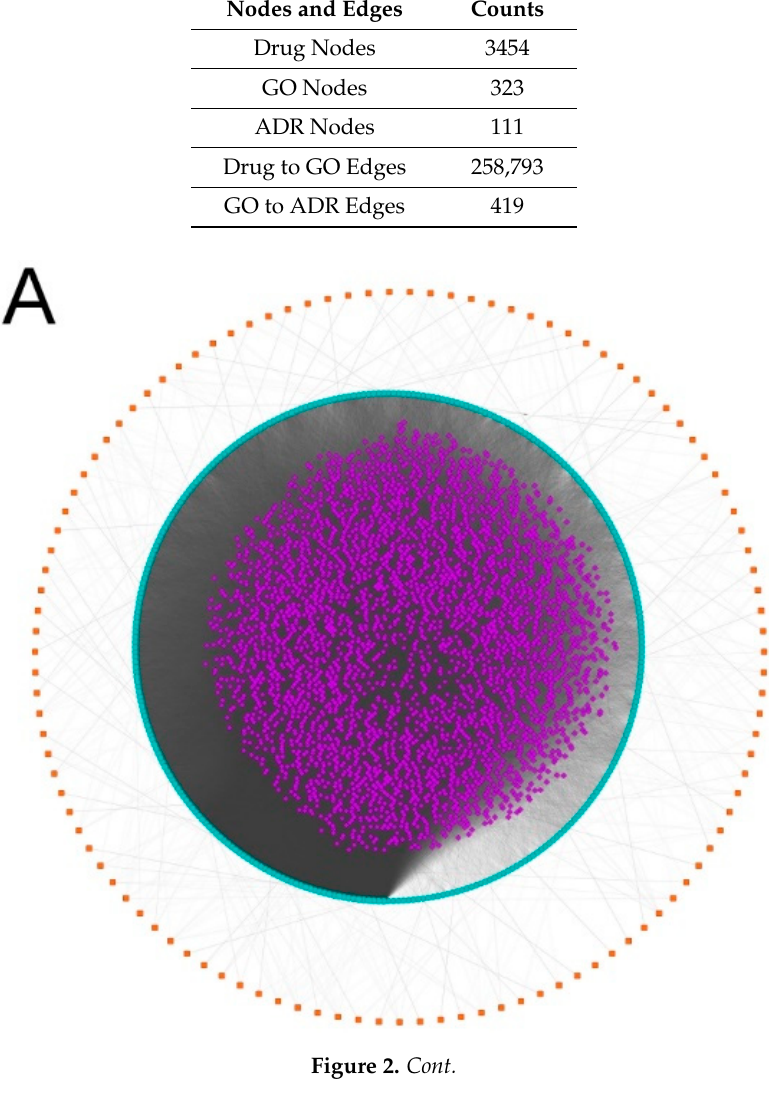
Table 1. Topological parameters of the Drug–GO–ADR tripartite network.